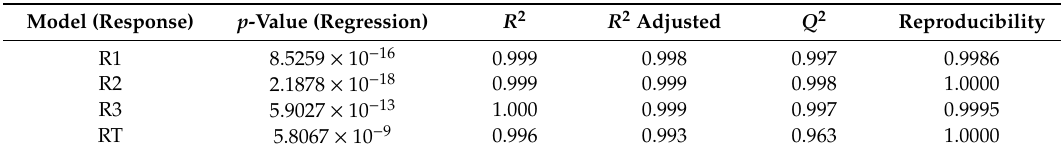
Table 2. Statistical significance and coe ffi cients of determination of mathematical models for each